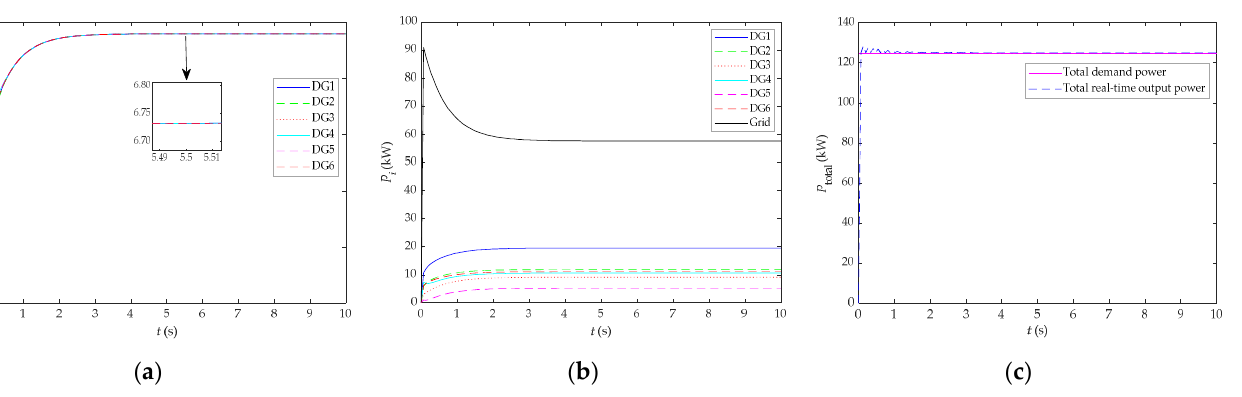
Figure 27. The change curves of variables of the system when the initial active output is set at zero: ( a ) change curves of each DG’s ICR; ( b ) change curves of each DG’s active output and grid output power; ( c ) change curves of the cumulative sum of each DG’s active output and grid output power as well as total demand power.